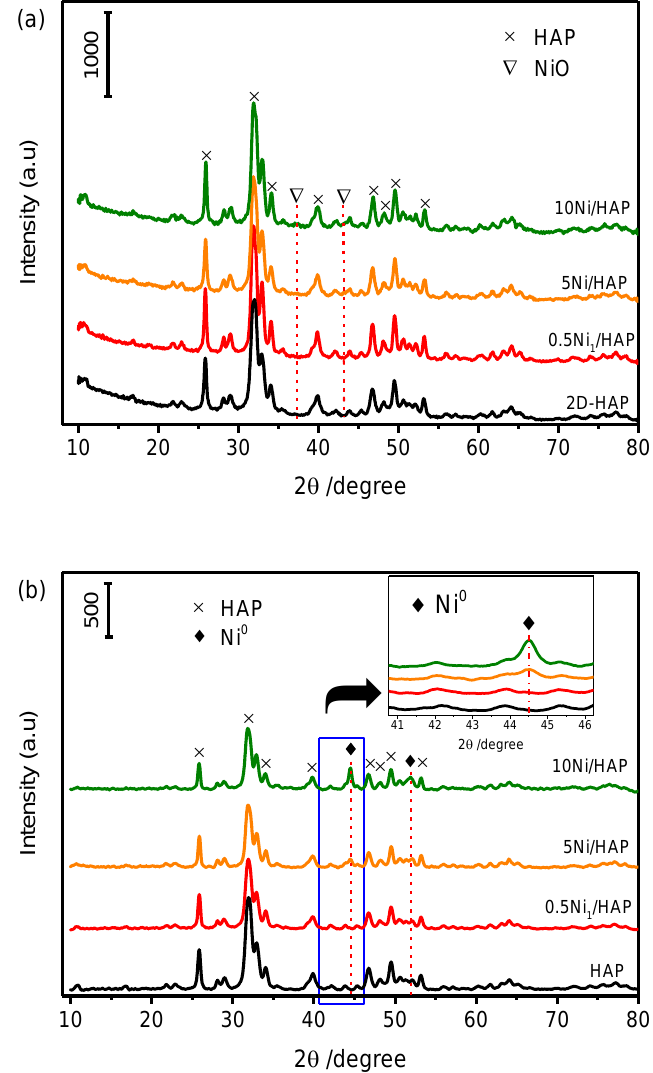
Figure 1. XRD patterns of hydroxyapatite (HAP) and Ni / HAP, before reduction ( a ), after reduction at 500 °C ( b ).